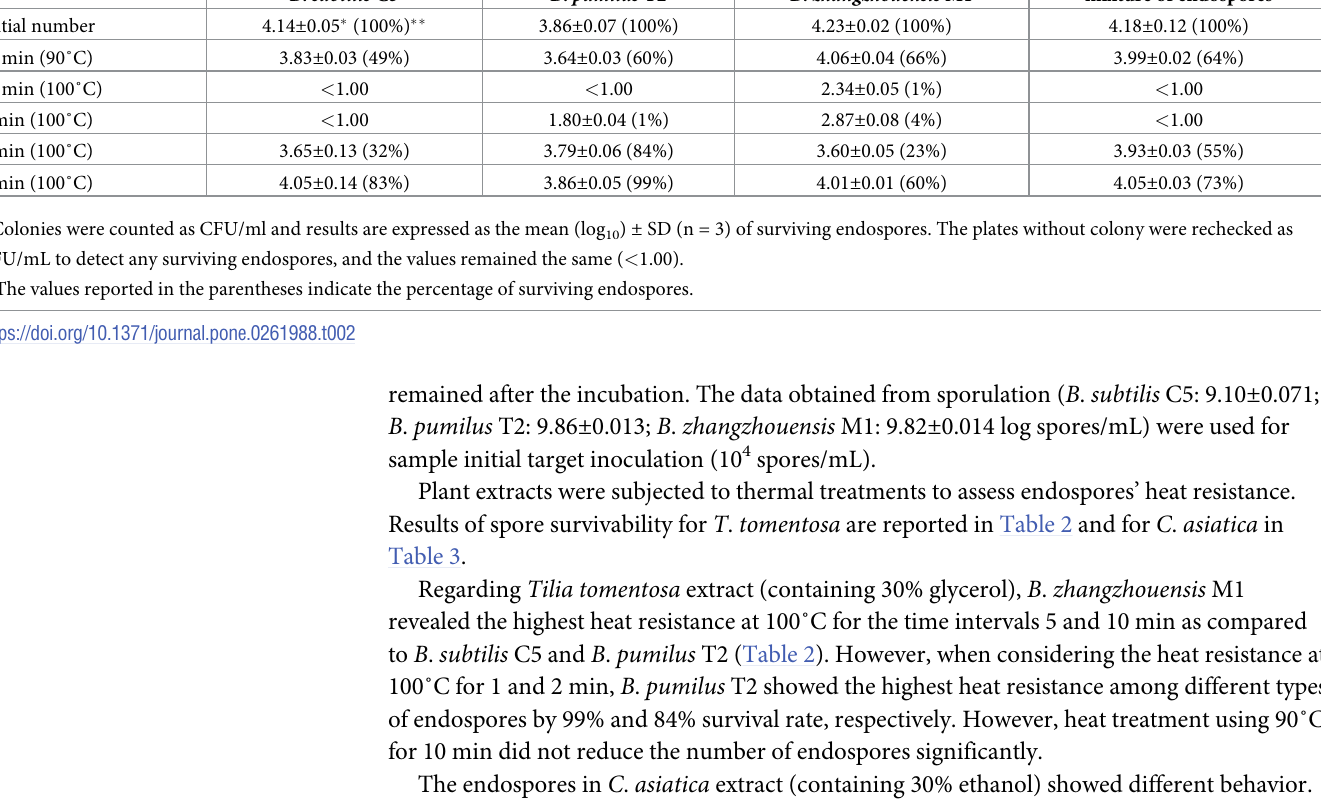
Results of spore survivability for T . tomentosa are reported in Table 2 and for C . asiatica in Table 3.